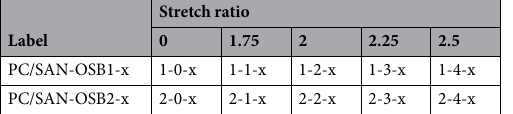
Table 2. Constituents of the PC/SAN-OSB Blends (x is 0, 0.5, 1.0, 1.5, 2.0, representing OSB mass fraction, 0 wt%, 0.5 wt%, 1.0 wt%, 1.5 wt% and 2.0 wt%, respectively).